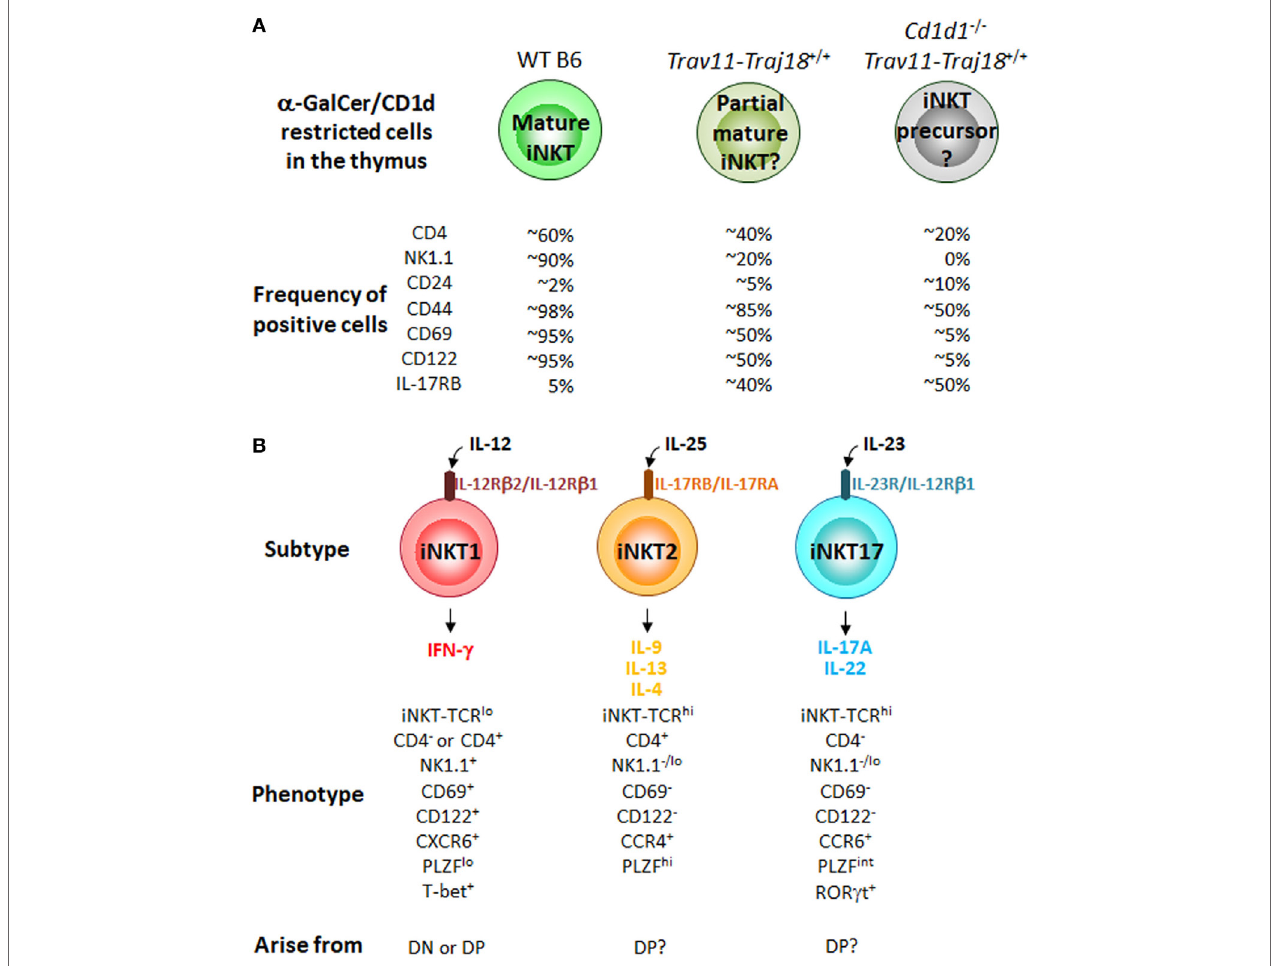
FiGURe 2 | CD1d restricted cells in iPSC-invariant natural killer T (iNKT)-derived cloned mice and iNKT cell subtypes in the thymus of B6 mice. (A) Percentage of CD1d-restricted α -GalCer/CD1d dimer + TCR β + cells positive for the indicated cell surface molecules in WT B6, Trav11 - Traj18 + / + and Cd1d1 − / − Trav11 - Traj18 + / + mice. (B) The iNKT cell subtypes previously characterized in the thymus of B6 mice. Their phenotypes and developmental pathways in the thymus are also shown. Function of iNKT cells is acquired through the development in the thymus distinct from conventional αβ T cells. All of the iNKT subtypes may arise from the CD1d-restricted α -GalCer/CD1d dimer + TCR β + cells in Cd1d1 − / − Trav11 - Traj18 + / + mice in panel (A) , while it still remains to be elucidated which signals control the divergence of iNKT1, iNKT2, and iNKT17 subsets.